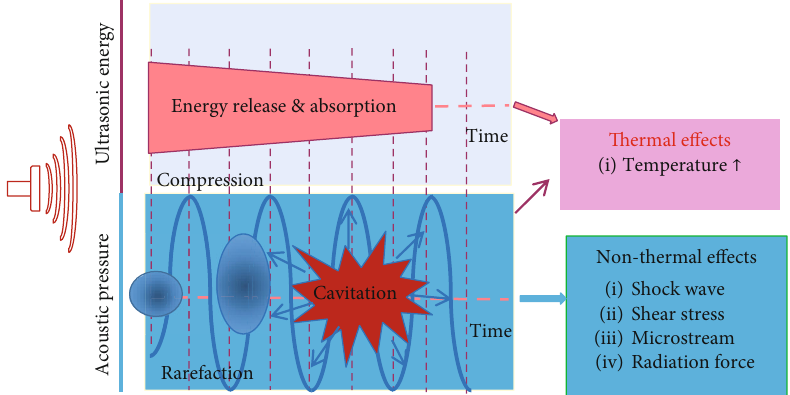
Figure 5: (a) The biophysical roles exerted by low-intensity ultrasound (LIUS) therapy includes thermal and nonthermal effects. The thermal effects of ultrasound result from the absorption of ultrasonic energy, and the creation ofheat depends on ultrasound exposure parameters, tissue properties, and beam configuration. As many as six biophysical effects including cavitation, acoustic radiation force, radiation torque, acoustic streaming, shock wave, and shear stress are considered nonthermal effects of ultrasound. Cavitation is perhaps the most widely studied biophysical effect and is described as the formation and oscillation of a gas bubble. In addition, the oscillation ofthe bubble